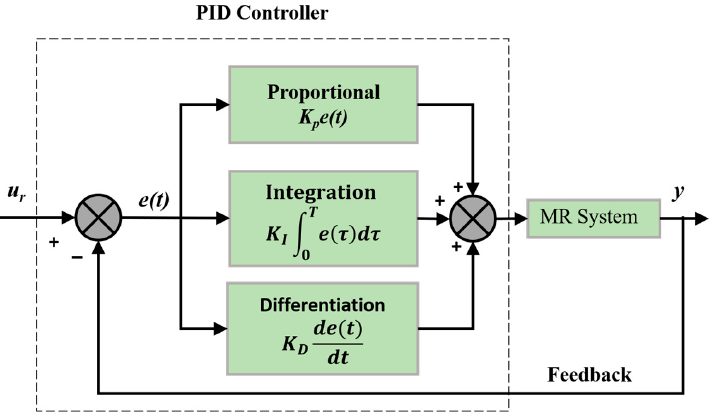
Figure 5. Block diagram of a PID controller [26]. Reproduced with permission from Choi, S. ‐ B. et al. State of the art of control schemes for smart systems featuring magnetorheological materials; published by Smart Materials and Structures, 2016.